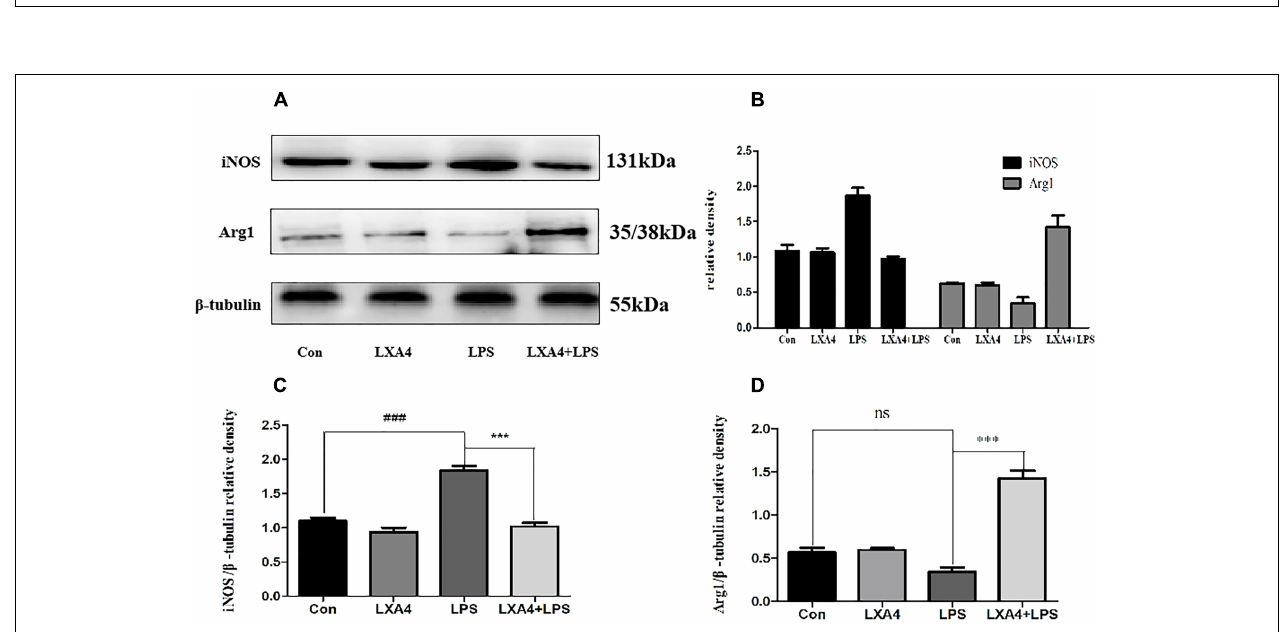
FIGURE 3 | Western blot analysis of the effect of LXA4 on iNOS and Arg1. (A–C) Western blot analysis of the protein level of iNOS in microglia. (A,B,D) Western blot analysis of the protein level of Arg1 in microglia, LPS upregluated M1 microglia biomarkers iNOS. With LXA4 intervention, iNOS expression decreased, M2 microglia biomarkers Arg1 expression increased significantly. ### , ∗∗∗ p < 0.001; n.s., no significance.